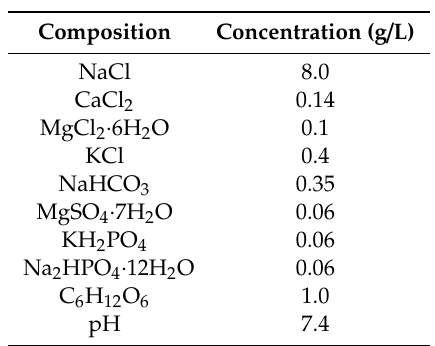
Table 2. The compositions of Hanks’ solutions